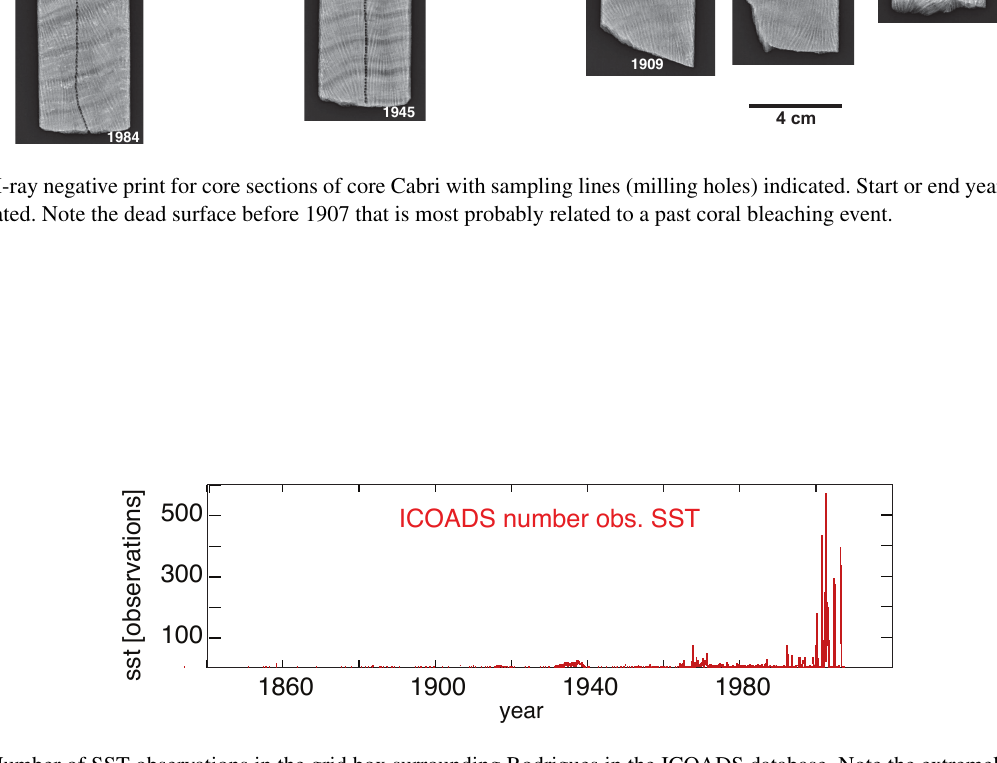
Figure A3. Number of SST observations in the grid box surrounding Rodrigues in the ICOADS database. Note the extremely sparse obser- vations, even in recent years (van Oldenborgh and Burgers,